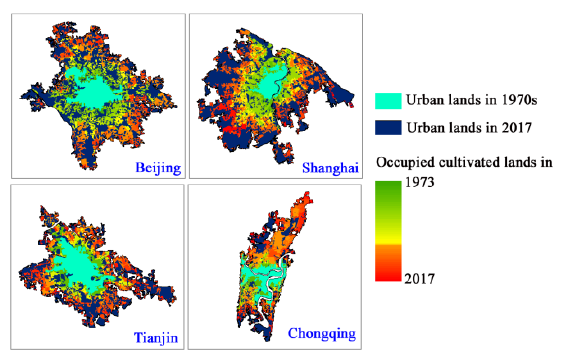
Figure 2 the impact of urban expansion on cultivated lands in